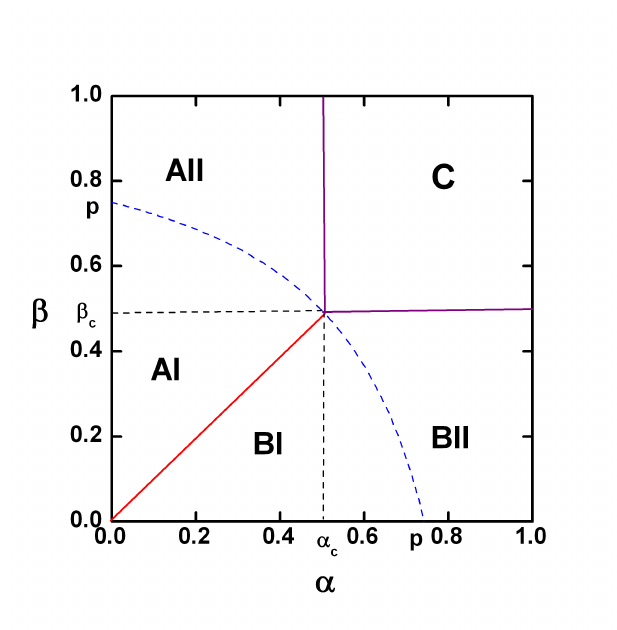
Fig. 1. Schematic representation of the open TASEP on a simple chain; for details see text.